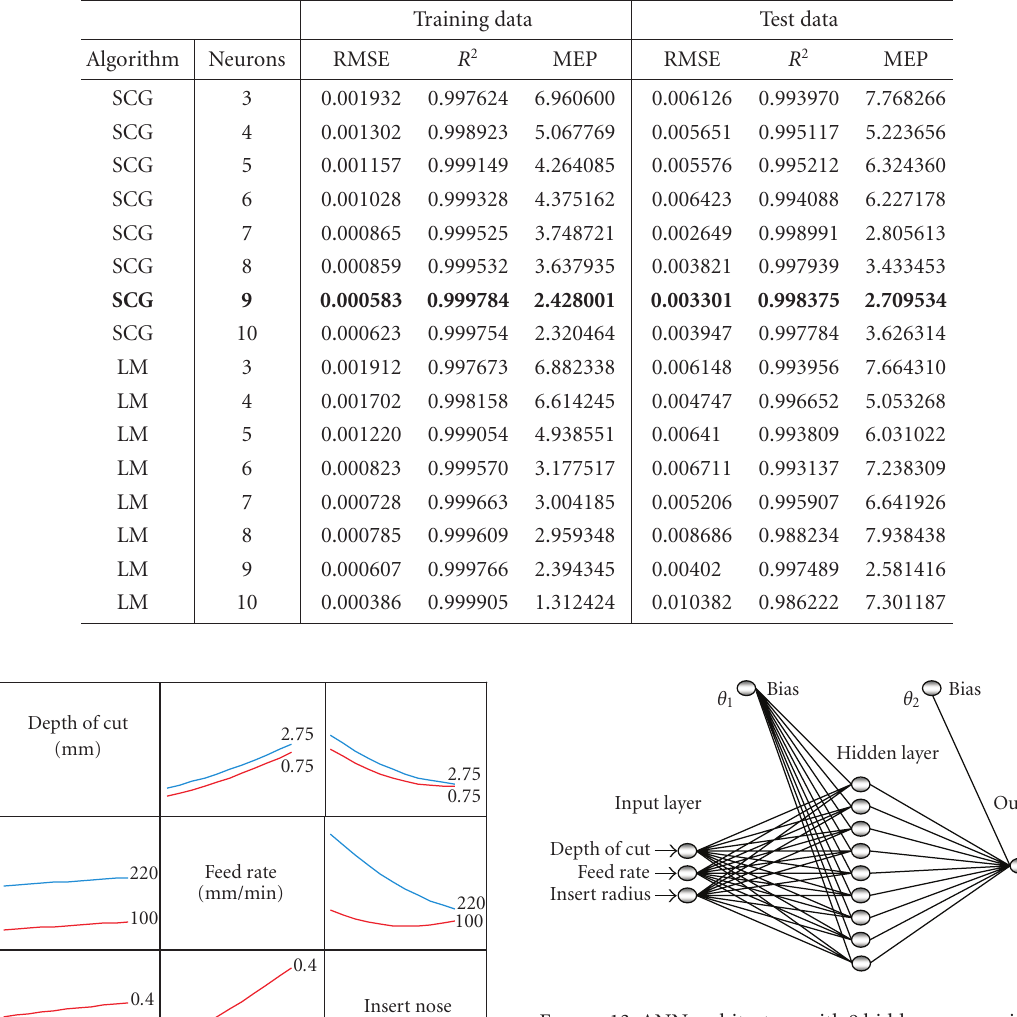
Figure 13: ANN architecture with 9 hidden neurons in a single hid- den